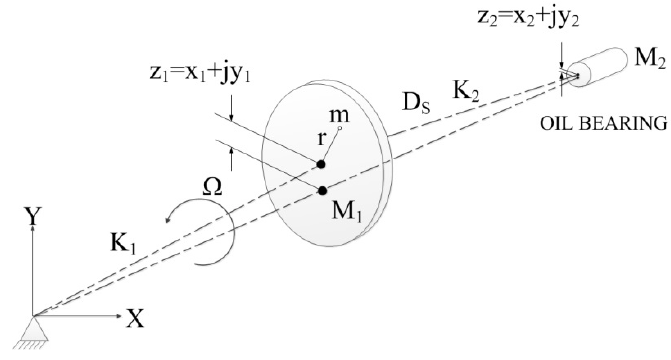
Figure 4. Rigid rotor system model.